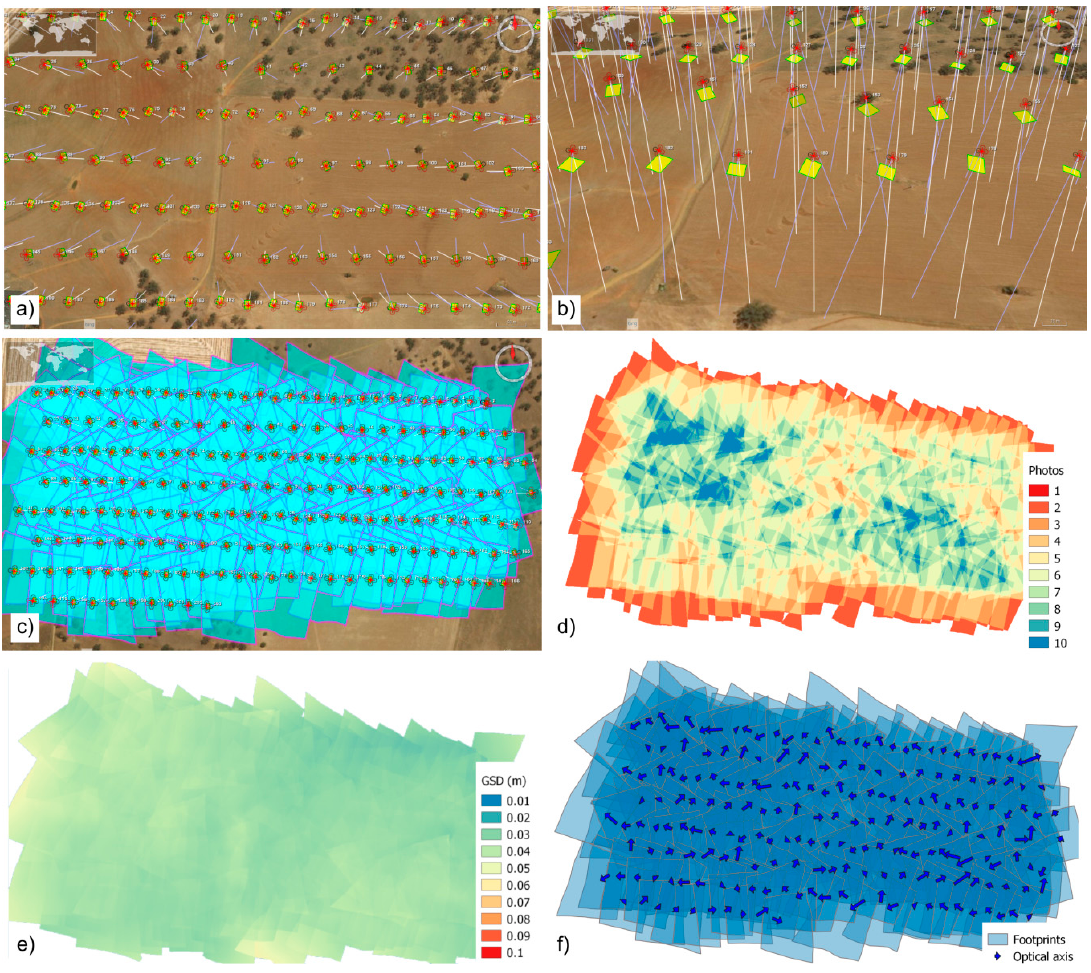
Figure 13. Control quality of a fixed-wing Remotely Piloted Aerial Systems (RPAS) flight: ( a ) and (b) image location of photographs (top and lateral views), ( c ) footprints map, ( d ) coverage map, ( e ) GSD map, and ( f ) direction and module (tilt angle) of optical axes.